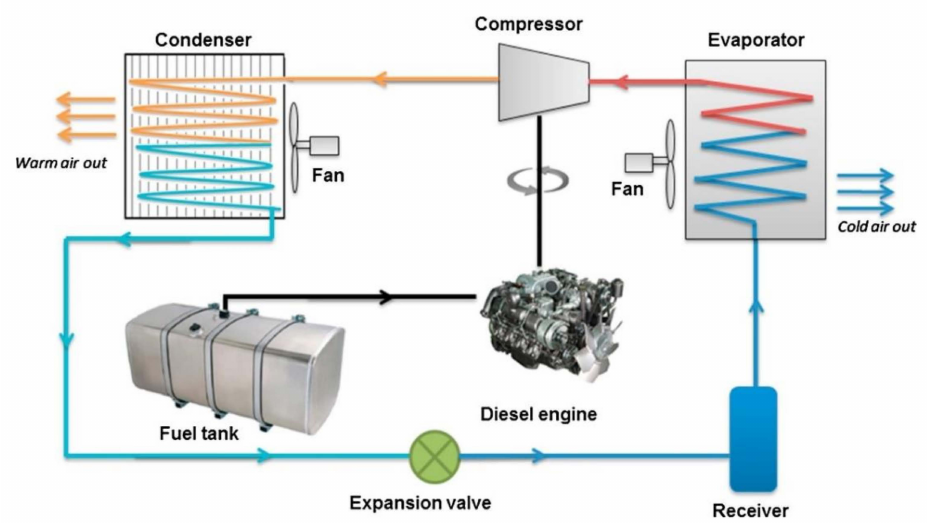
Figure 6. Schematic diagram of vapour compression transport refrigeration unit driven by a diesel engine. Reprinted from ref.